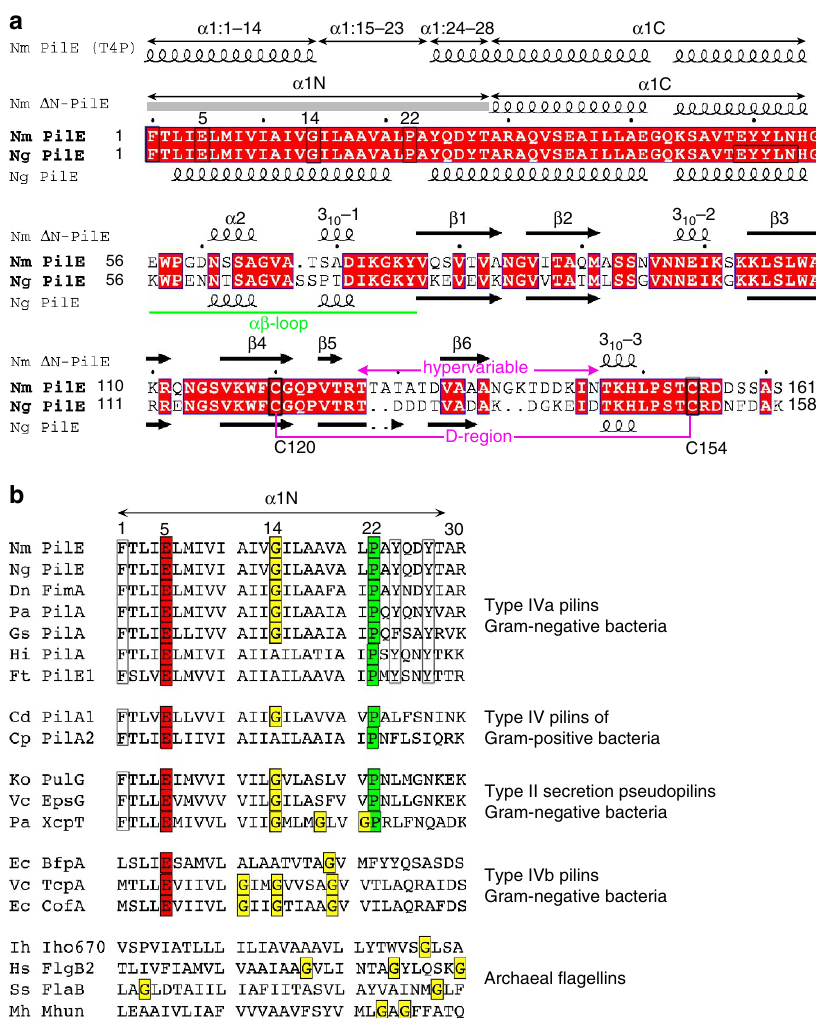
Figure 1 | Sequence alignment between N. meningitidis and N. gonorrhoeae PilE and other Type IV pilin-like proteins. ( a ) Amino-acid sequence alignment between N. meningitidis (Nm) and N. gonorrhoeae (Ng) PilE, with secondary structures indicated above and below the sequences, respectively, based on the crystal structures of Nm D N-PilE (residues 29–161, this study) and full-length Ng PilE 9,11 . A grey bar represents a 1N, which is absent in the Nm D N-PilE structure. The secondary structure of Nm PilE a 1 within the T4P filament is indicated at the top of the panel based on the cryoEM density map. The amino-acid alignment was performed using CLUSTAL OMEGA 69 with manual adjustments and visualized using ESPript 70 . Identical residues are shown in white font on a red background. Residues of interest are boxed and the conserved disulfide-bonded cysteines are connected. ( b ) N-terminal amino-acid sequence alignment among Type IV pilins from Gram negative and Gram positive bacteria, Type II secretion pseudopilins and archaeal flagellins. Conserved residues are boxed and/or highlighted. Glycines are also highlighted in the archaeal flagellins although their positions are not conserved. Nm PilE, N. meningitidis PilE (GenBank accession number WP_014573675), Ng PilE, Neisseria gonorrhoeae PilE (for 2HI2, P02974), Dn FimA, Dichelobacter nodosus (X52403), Pa PilA, Pseudomonas aeruginosa PilA (P02973); Gs, Geobacter sulfurreducens PilA (2M7G_A); Ft PilE1, Francisella tularensis Schu S4 PilE1 (CAG45522); Hi, non-typeable Haemophilus